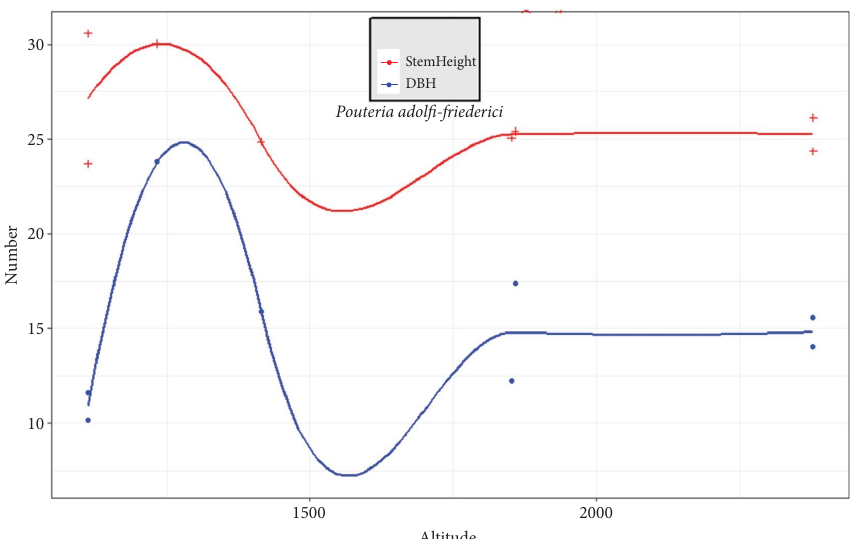
Figure 8: Distribution of the stem height and DBH of P. adolf-friedericii along altitudinal